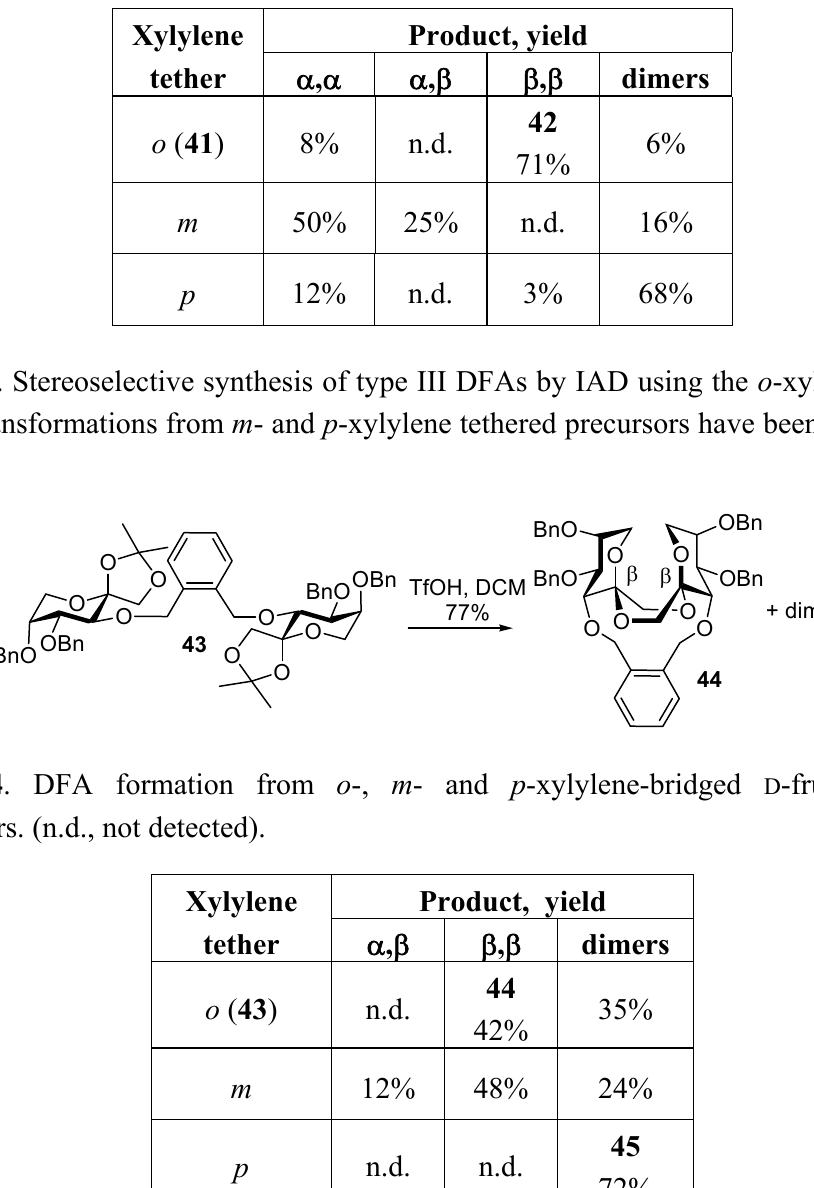
Table 3 . DFA formation from o -, m - and p -xylylene-bridged D -fructofuranose precursors (n.d., not detected).